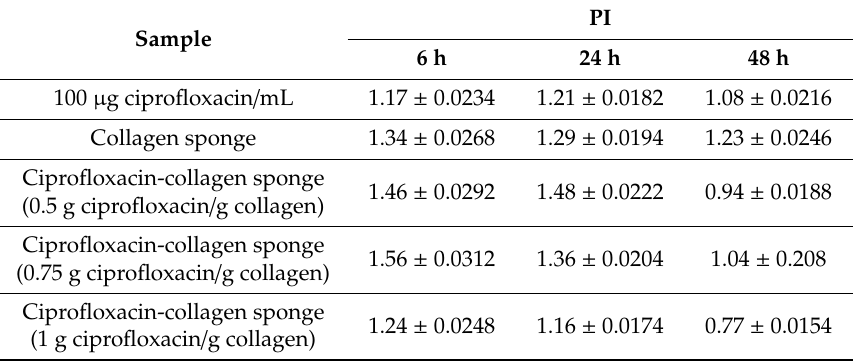
Table 3. HUVEC proliferation at di ff erent time exposure to ciprofloxacin-based